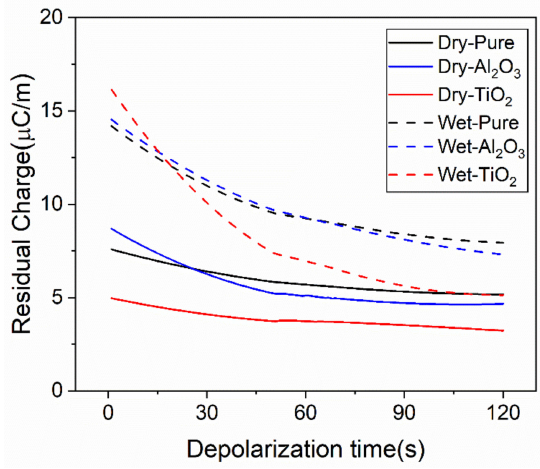
Figure 7. Residual charge of dry and damp